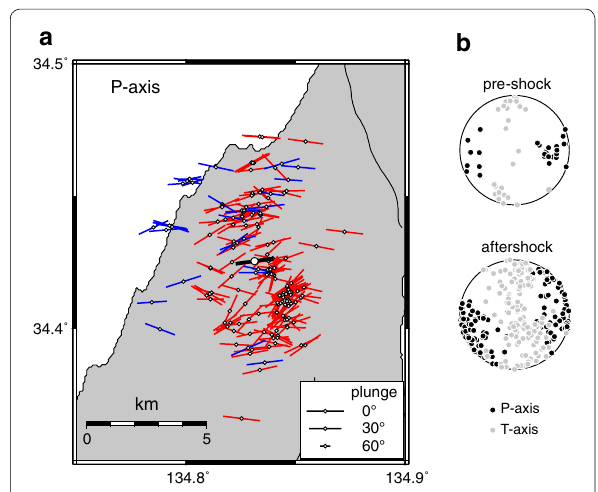
Fig. 6 P- and T-axes of focal mechanism solutions determined in the present study. a P-axis distributions (blue bars: pre-shocks, red bars: aftershocks). A bold bar shows P-axis orientation of the mainshock derived from the best double-couple CMT solution shown in Fig. 1b. The length of each bar corresponds to the plunge of the axis. b Lower hemisphere stereonet plot of P- and T-axes for pre-shocks and aftershocks, respectively